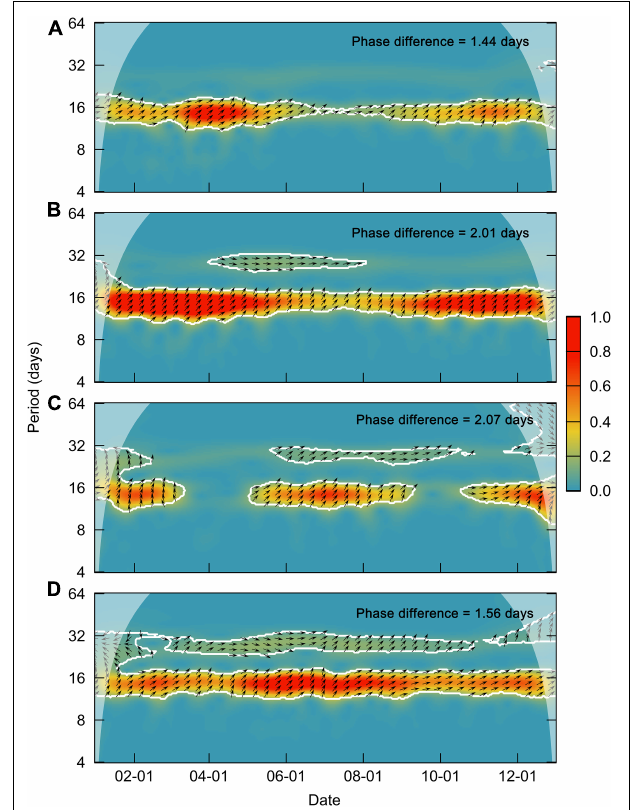
FIGURE 11 | Cross-wavelet power spectrum between daily Chl- a and the tidal current in areas (A–D) . The white lines and black arrows represent a significance level of 0.05 and the phase angle between the two time series,